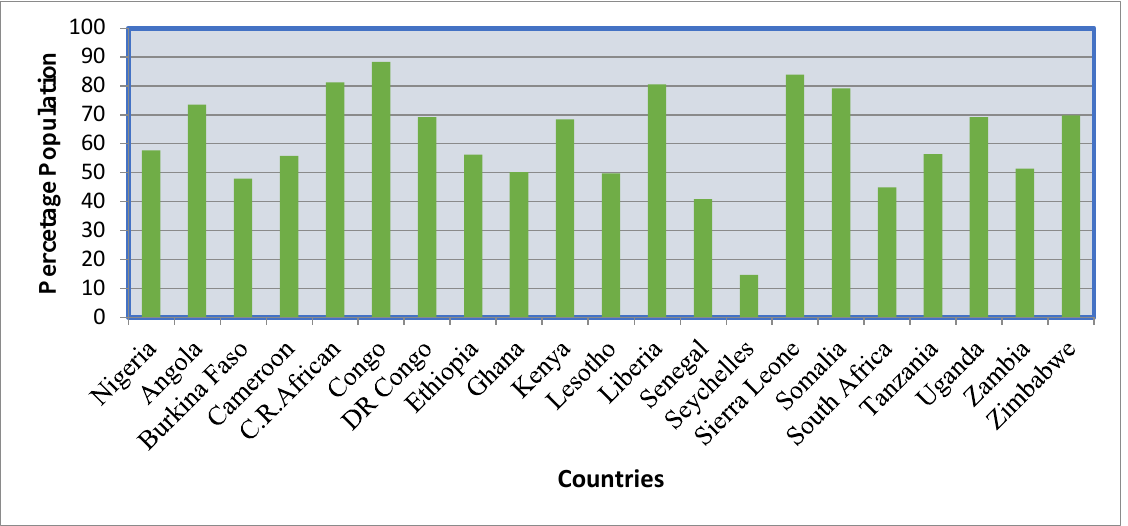
Figure 6. Prevalence of moderate or severe food insecurity in the percentage of the population of some Sub-Saharan countries in 2019. Source: https://data.worldbank.org/indicator/SN.ITK.MSFI.ZS?locations=ZG . Accessed on 25 May 2022.